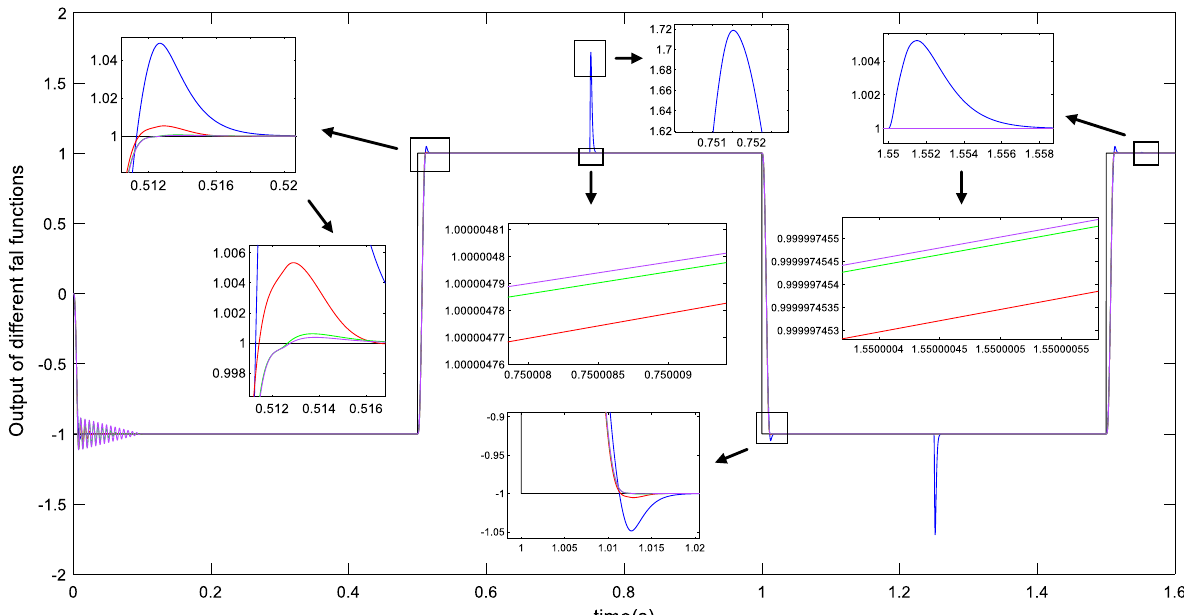
Fig. 13 Input square wave (black) and the outputs of the system based on the different fal functions (default fal : blue, fal arcsinh : red, fal arctan : green, and fal tanh : purple)